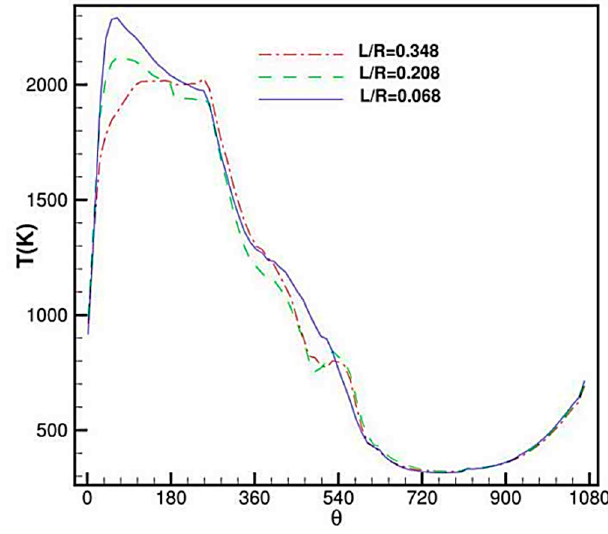
Figure 10. Temperature distribution at various spark plug positions (Hwang et al. [80]).